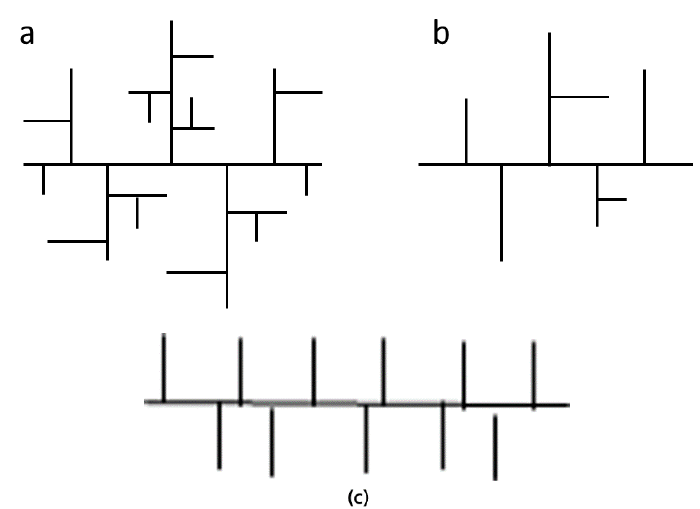
Figure 1. ( a ) Autoclave product (LDPE-A), ( b ) tubular product (LDPE-T) both of molecular weight ≈ 5 × 10 5 g mol − 1 [12–14], ( c ) linear low-density polyethylene (LLDPE) [15].